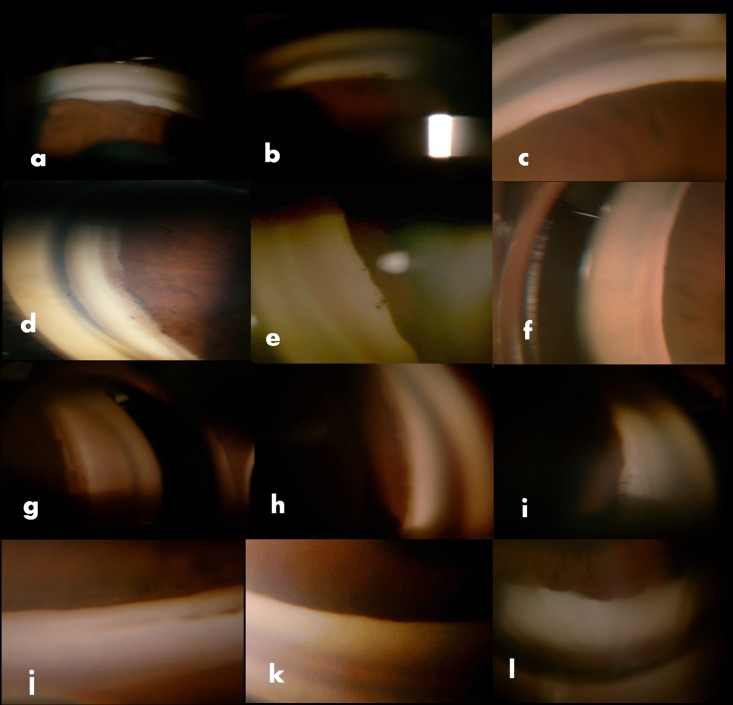
Comparison of 4 quadrant (from above to below superior, nasal, temporal and inferior in that order) gonioscopic features of eyes with primary angle closure glaucoma requiring 0 medicines (group 1-a,d, g and i) with that requiring 1 medicines (group 2-b, e, h and k) or >2 medicines (group 3-c, f, i, l)showing definite differences in gonioscopic features among eyes with different number of medicines, especially group 1 and group 3.